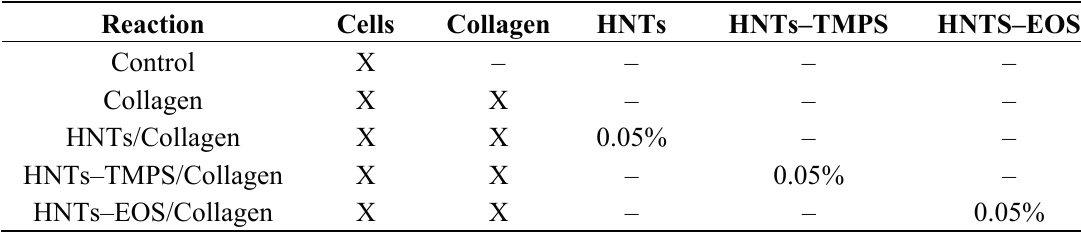
Table 1. Experimental groups used to evaluate cytotoxicity of halloysite clay nanotubes (HNTs) derivatives. Reaction Cells Collagen HNTs HNTs–TMPS HNTS–EOS Control X – – – – Collagen X X – – – HNTs/Collagen X X 0.05% – – HNTs–TMPS/Collagen X X – 0.05% – HNTs–EOS/Collagen X X – – 0.05% X: indicate the presence of a component; –: indicate